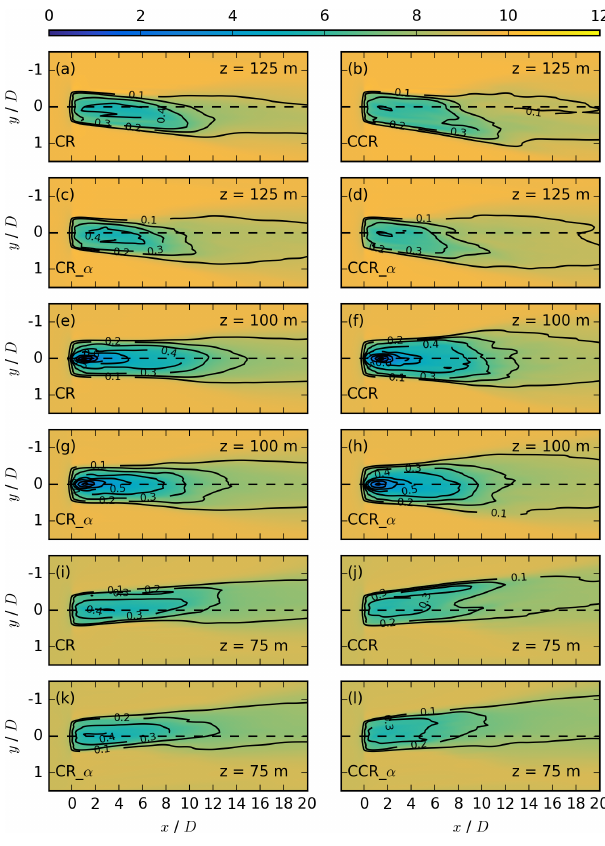
in meters ∗ at the same ∗